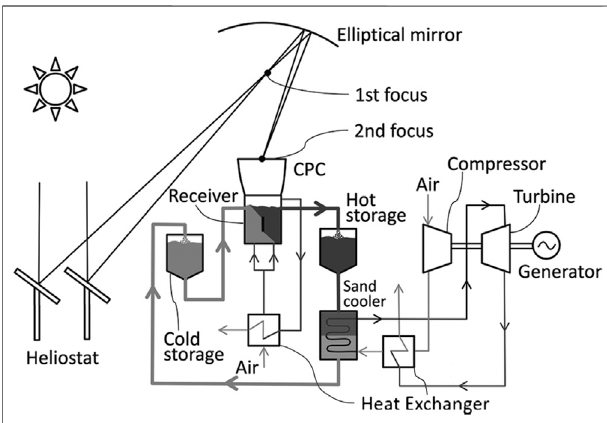
FIGURE6| Theschematicofthesolargenerationunitbasedonthetwo- towertypesolarreceiverforthermalenergystorage(reprintedfromMatsubara et al. (2015), with the permission of Elsevier